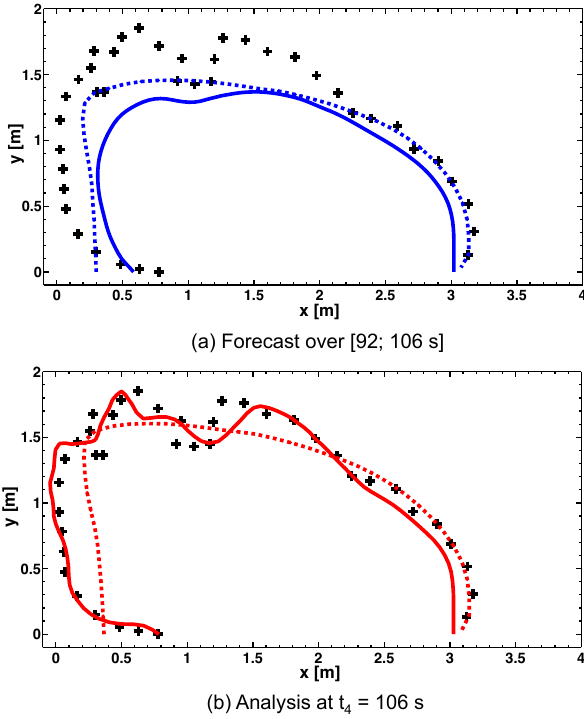
Figure 15. Comparison between simulated (lines) and observed (symbols) front positions at time t 4 = 106s in the controlled grass- land burning experiment. The simulated front position is the mean position calculated as the average of the EnKF ensemble; dashed lines (solid lines) correspond to the PE-based (SE-based) simula- tions. (a) Forecast (with EnKF update at t 3 = 92s). (b) Analysis (with EnKF update at t 4 = 106s).